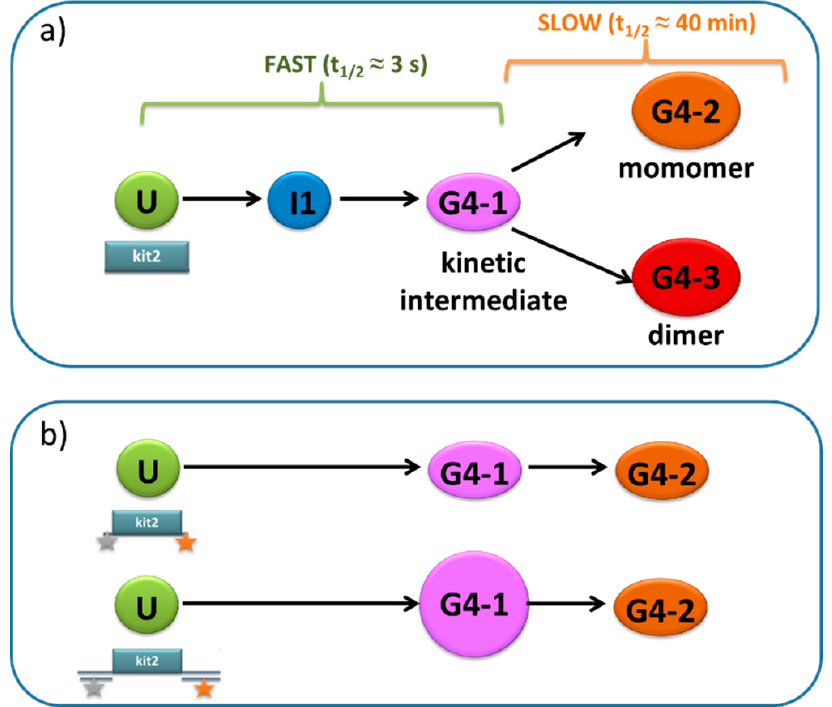
Figure 3. Folding of kit2 as determined in bulk ( a ) or by single molecule FRET ( b ) analyses. U refers to the unfolded (or pre-folded) state; I2 to an uncharacterized short-lived intermediate; and G1, G2, and G3 to a kinetically favored, a monomeric, and a dimeric G-quadruplex, respectively.